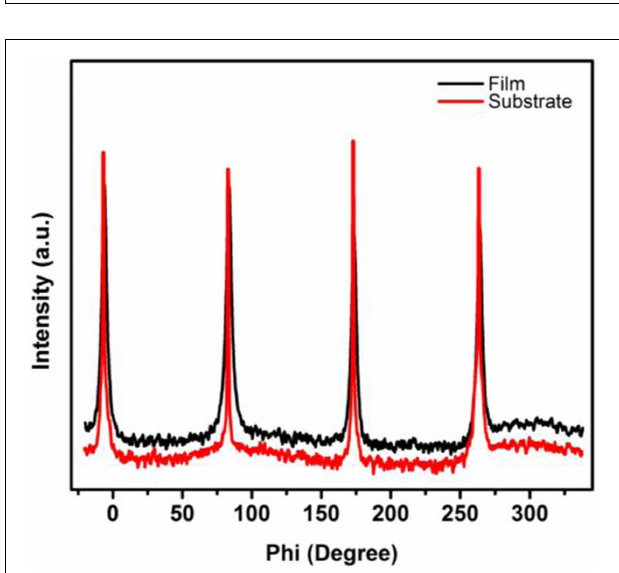
FIGURE 2 | Phi-scans of (002) oriented film grown at 650°C and the MgAl 2 O 4 substrate